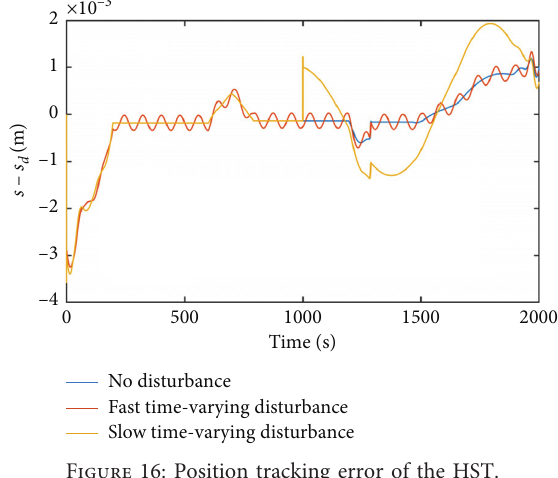
Figure 13: Position and velocity trajectory for HST.